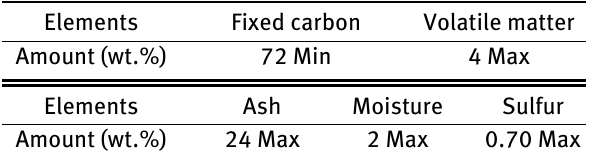
Table 4: Chemical compositions of MCA.